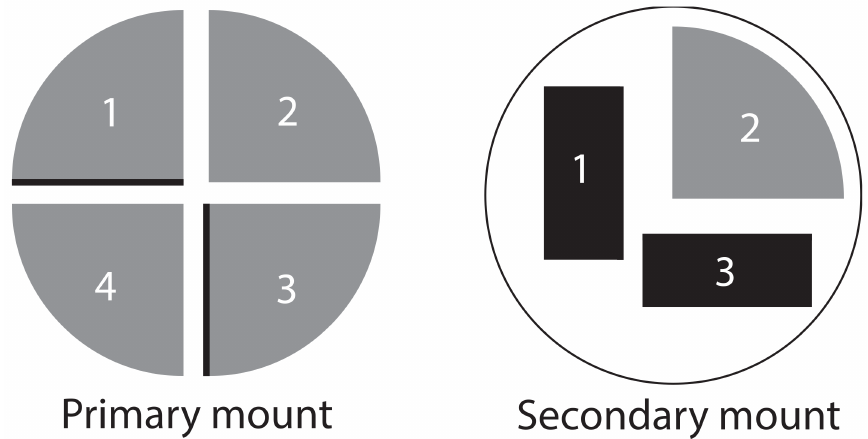
Figure 3. Mounting schematic displaying the basal surface of the two mounting stages. The primary grain mount was quartered, and three quarters were reoriented and made into a second mount to display one basal surface and two cross-sectional surfaces for analysis. Cross-sectional surfaces are indicated in